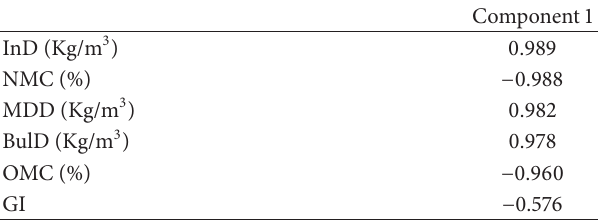
Table 6: Component matrix a